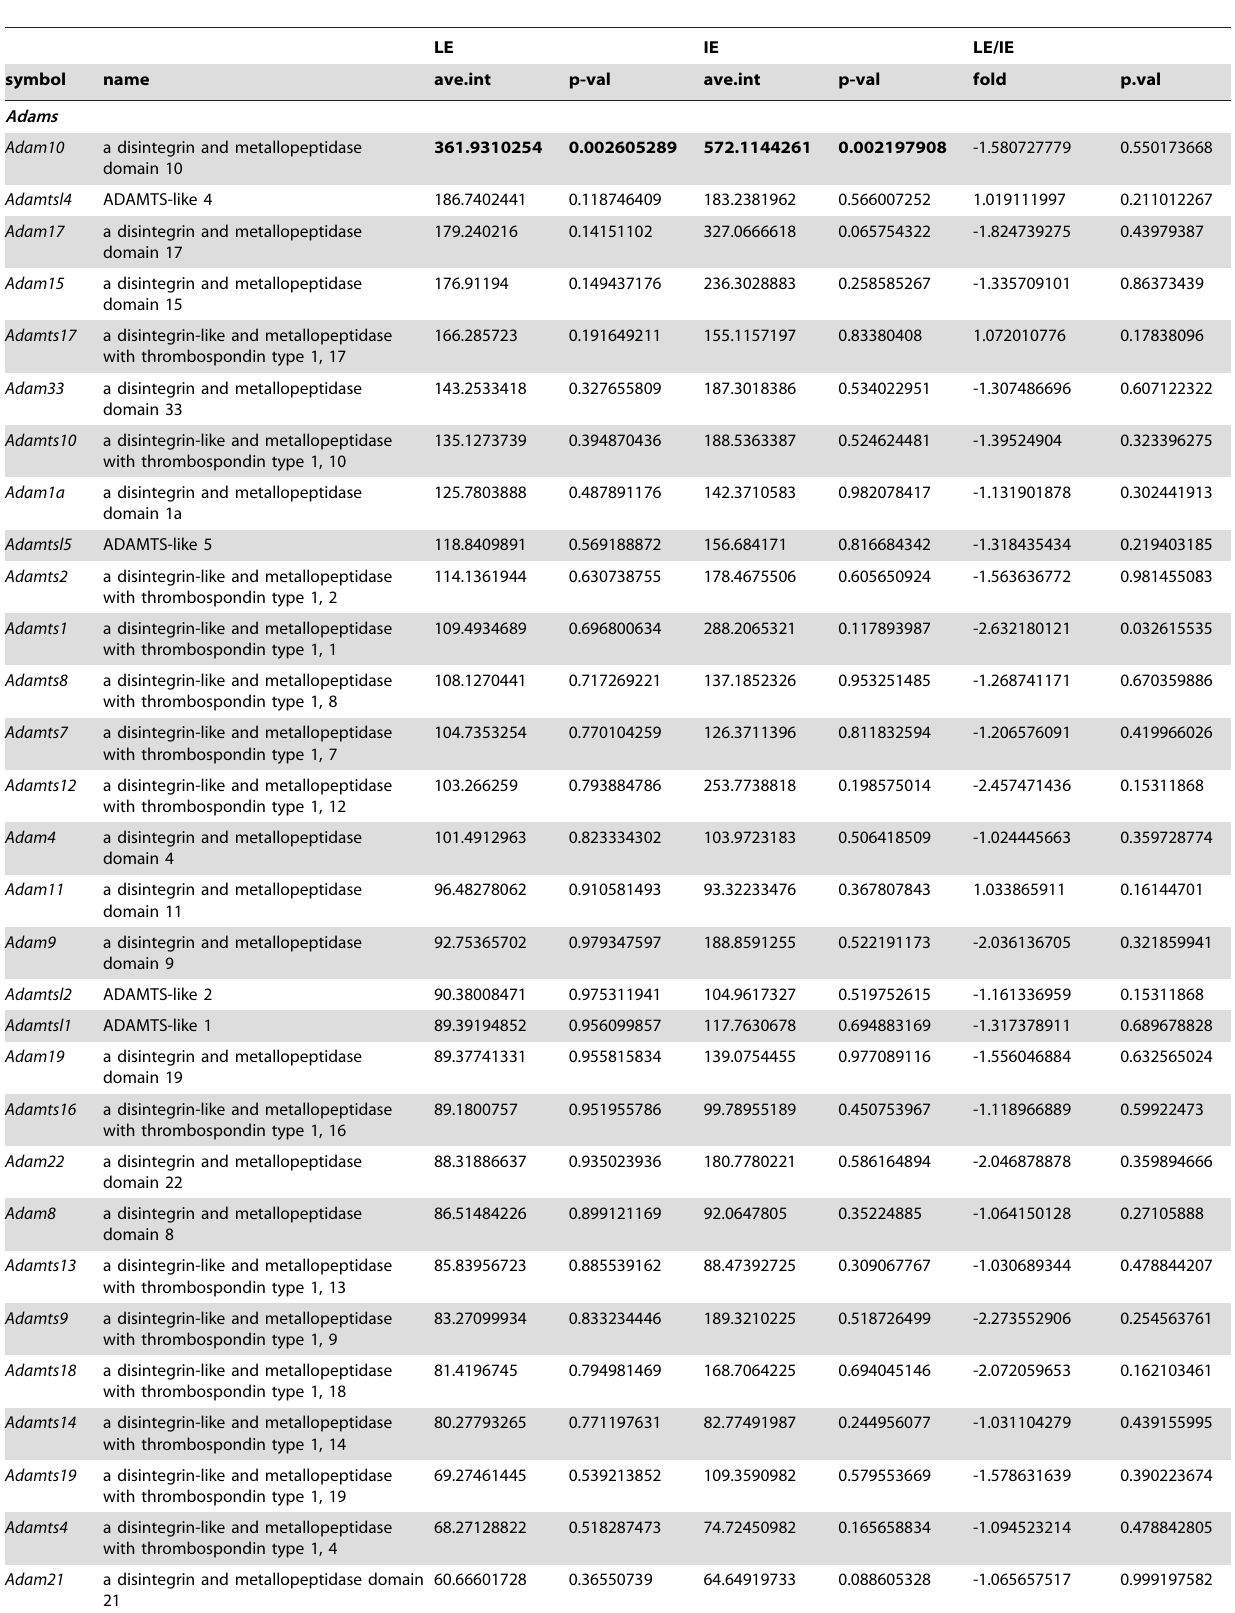
Table 5. Expression of genes in the Adams family